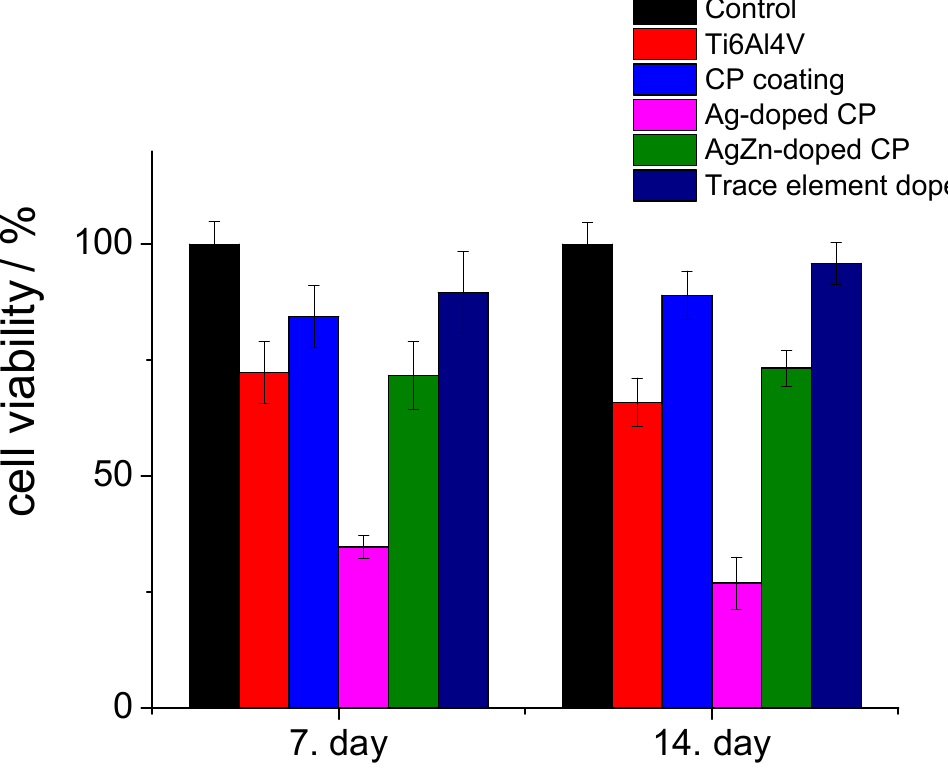
Figure 7. Cell viability percentage on the investigated samples compared to the positive control. Positive control: MG-63 cells were grown in well plates with no samples. Results are demonstrated by the mean value and standard deviation of six replicates of each sample and were normalized to MG-63 cells growth on a well plate (control = 100%).